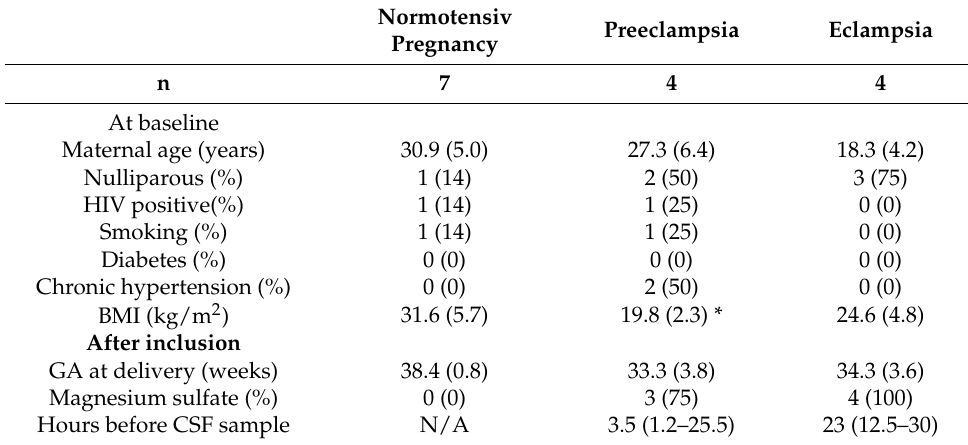
Table 1. Background characteristics of the